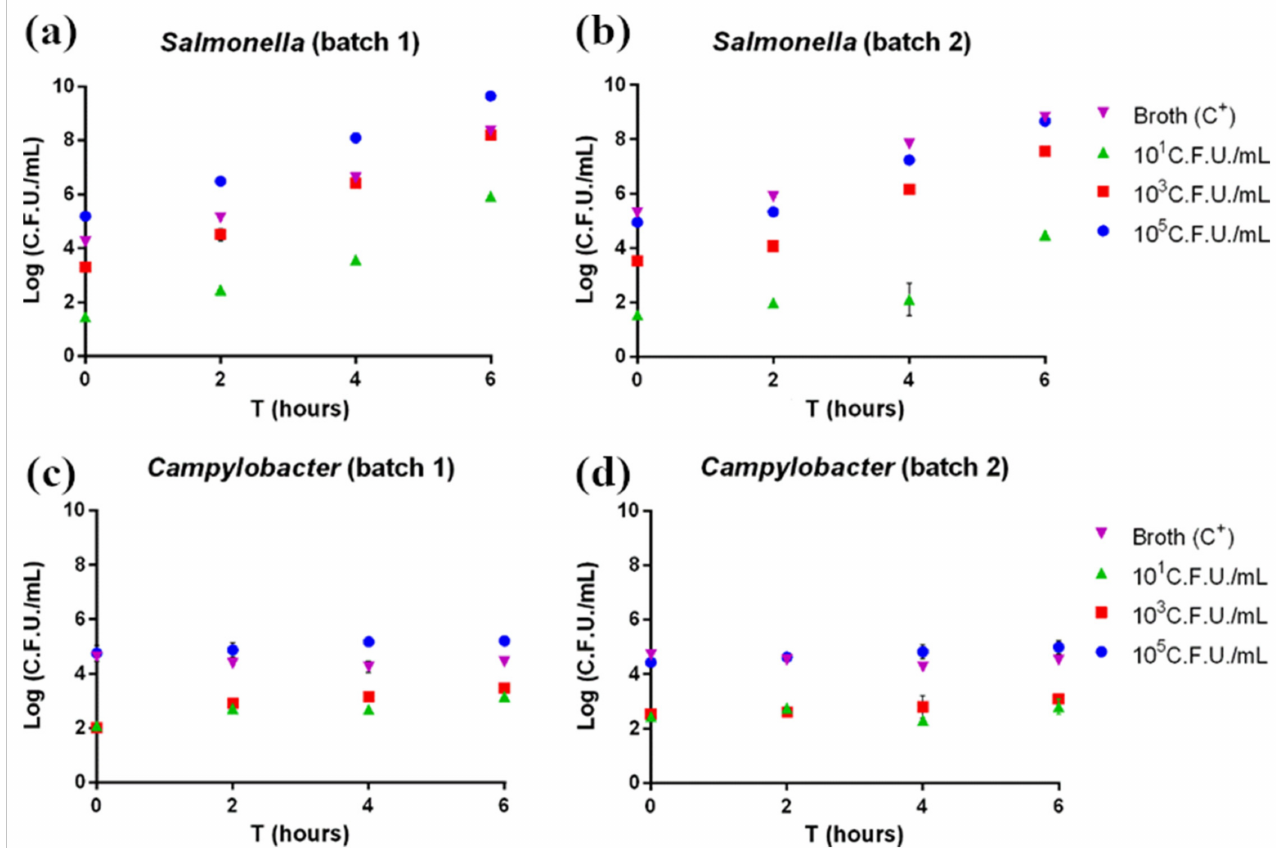
Figure 1. ( a , b ) Salmonella and ( c , d ) Campylobacter plate count. Each sample was measured in triplicate. Mean ± SD is shown. The full dataset can be found in Table